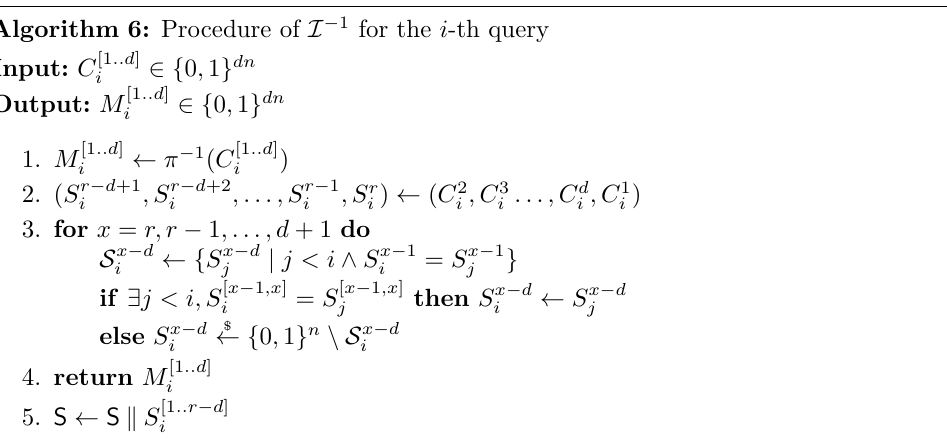
Figure 9: Definition of I and I − 1 for the SPRP proof of E 1 ,d,r . Initially, S is empty, and S is given to A after it makes all the q